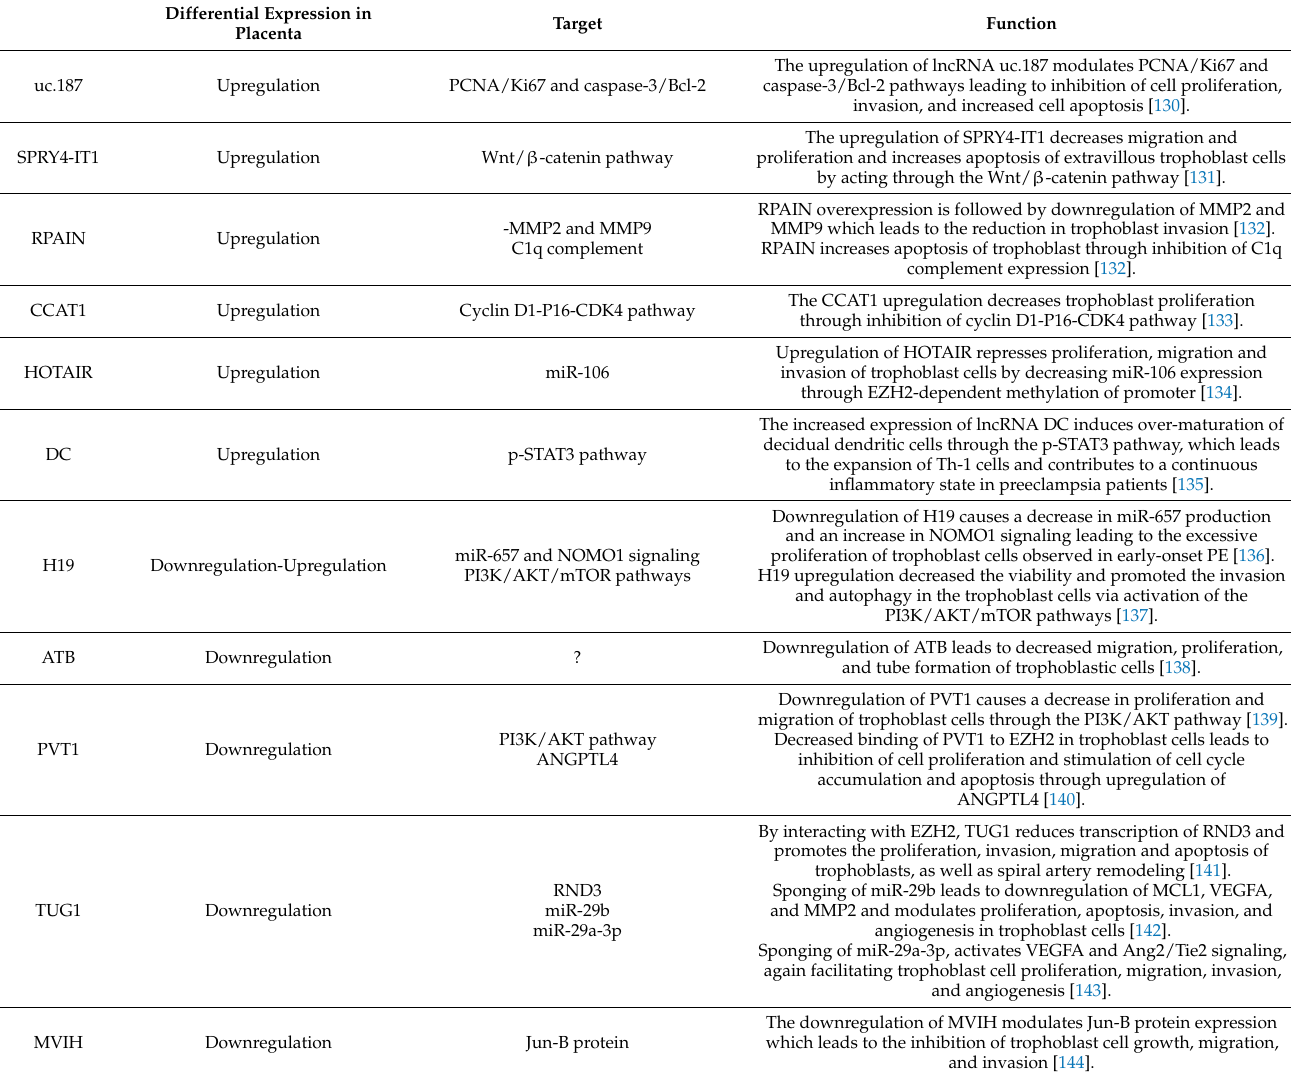
Table 2. Dysregulation of specific lncRNAs in PE and proposed mechanisms of